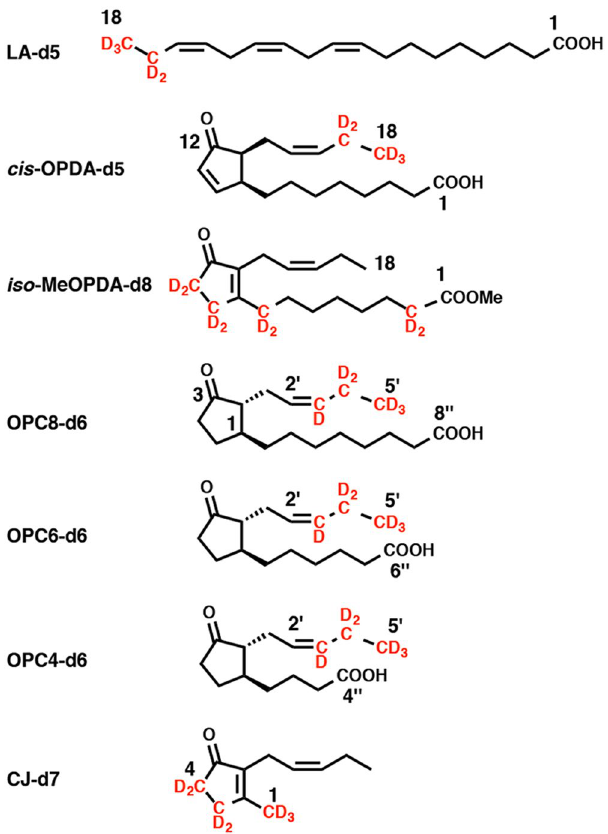
Figure 3. Chemical structures of deuterium-labeled compounds used in this study. Way of numbering the carbon atoms of OPDA-d5 was according to that of previous report 21 , and those of OPC8-d6, OPC6-d6, and OPC4-d6 were according to the report of Matsuura et al . 36